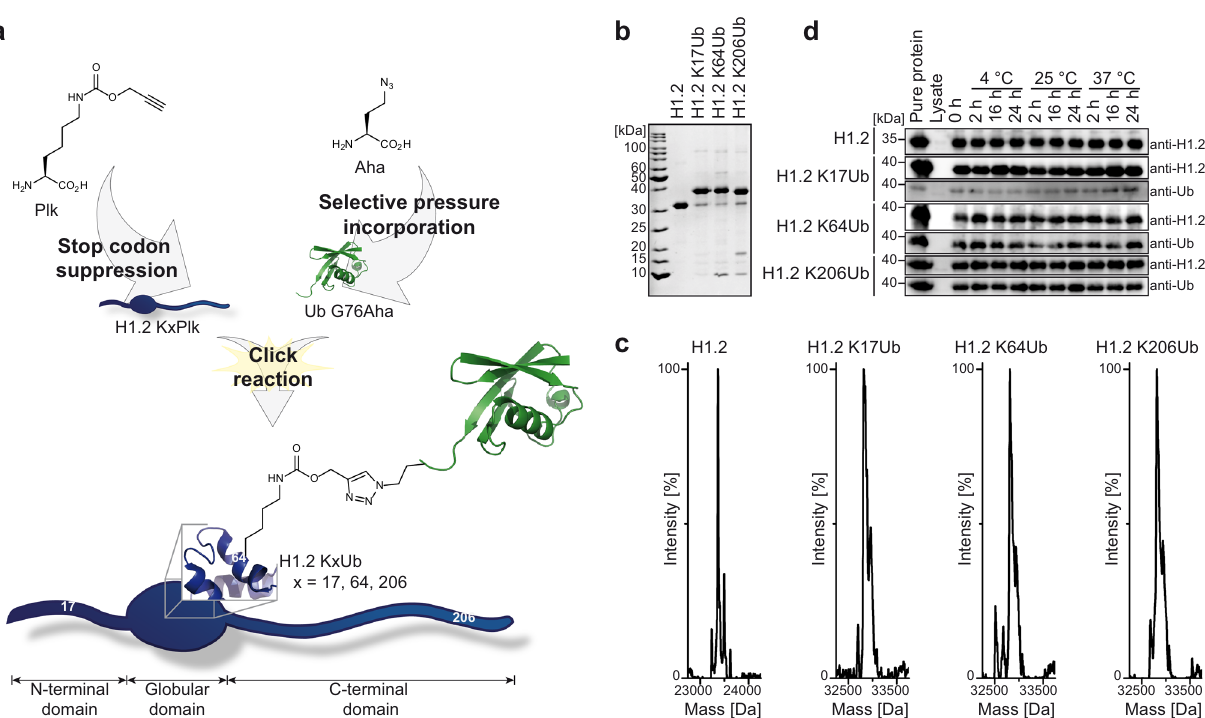
Fig. 1 Generation of site-speci fi cally ubiquitylated H1.2. a Scheme representing the generation of ubiquitylated histones. Aha was incorporated into Ub via selective pressure incorporation and Plk into H1.2 by stop codon suppression. Finally, the proteins were linked by CuAAC. H1.2 was ubiquitylated at positions K17, K64, and K206. b Non-ubiquitylated H1.2 and H1.2 KxUbs resolved by SDS-PAGE followed by Coomassie blue staining. c LC-MS analysis of full-length proteins. H1.2 calc. 23370 Da, measured 23370Da; H1.2 K17Ub calc. 32813 Da, measured 32818 Da; H1.2 K64Ub calc. 32813 Da, measured 32816Da; H1.2 K206Ub calc. 32813 Da, measured 32815 Da. d Stability assay of H1.2 and H1.2 KxUbs. Proteins were incubated in HEK 293T cell lysate and analyzed by western blot showing constant levels of the respective proteins, indicating the stability of the conjugates over time at various